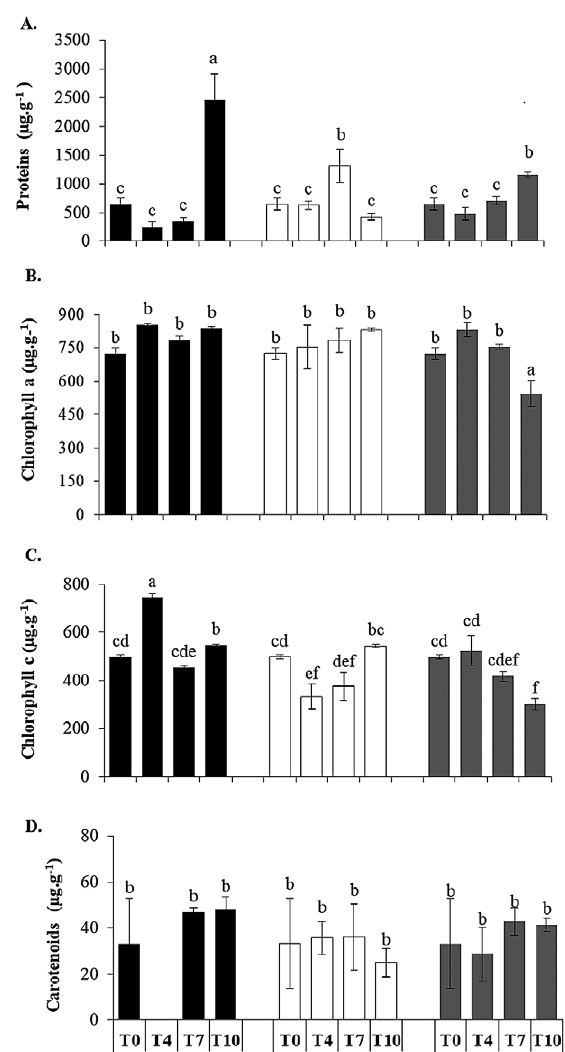
Fig. 4. – Absorption spectrum of buffer extract and area under the Fig. 3. – A, total soluble proteins; B, chlorophyll a ; C, chlorophyll c ; curve (AUC) of maximal absorption bands at 220-240 and 260-280 and D, carotenoids of Sargassum filipendula over 10 days of expo- nm. A, general UV spectrum at T4; B, C and D, the AUC (n=5; sure to PAR, PAR+UVA and PAR+UVB radiation treatments (n=5; mean±SD) at T4, T7 and T10 of radiation exposure, respectively, mean±SD). T0 represents samples before the start of the experiment at two specific absorption bands, 220-240 and 260-280 nm. Let- and T4, T7 and T10 correspond to the respective exposition time. ters indicate differences according to unifactorial ANOVA and Letters indicate differences according to bifactorial ANOVA and the Newman-Keuls post hoc test (p<0.05). The analyses were per- the Newman-Keuls post hoc test (p<0.05). formed for each absorption band